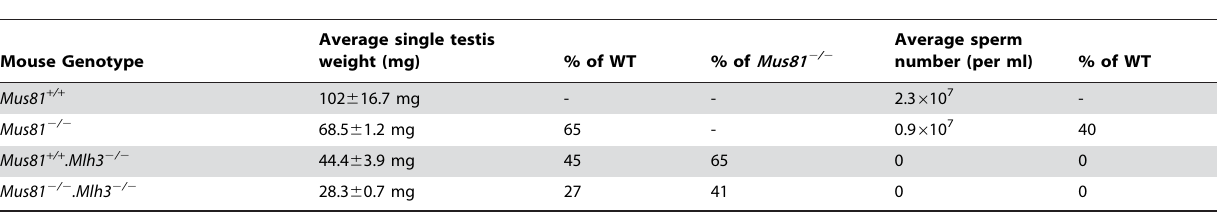
Table 1. Mus81 mice show reduced testis size and sperm number.